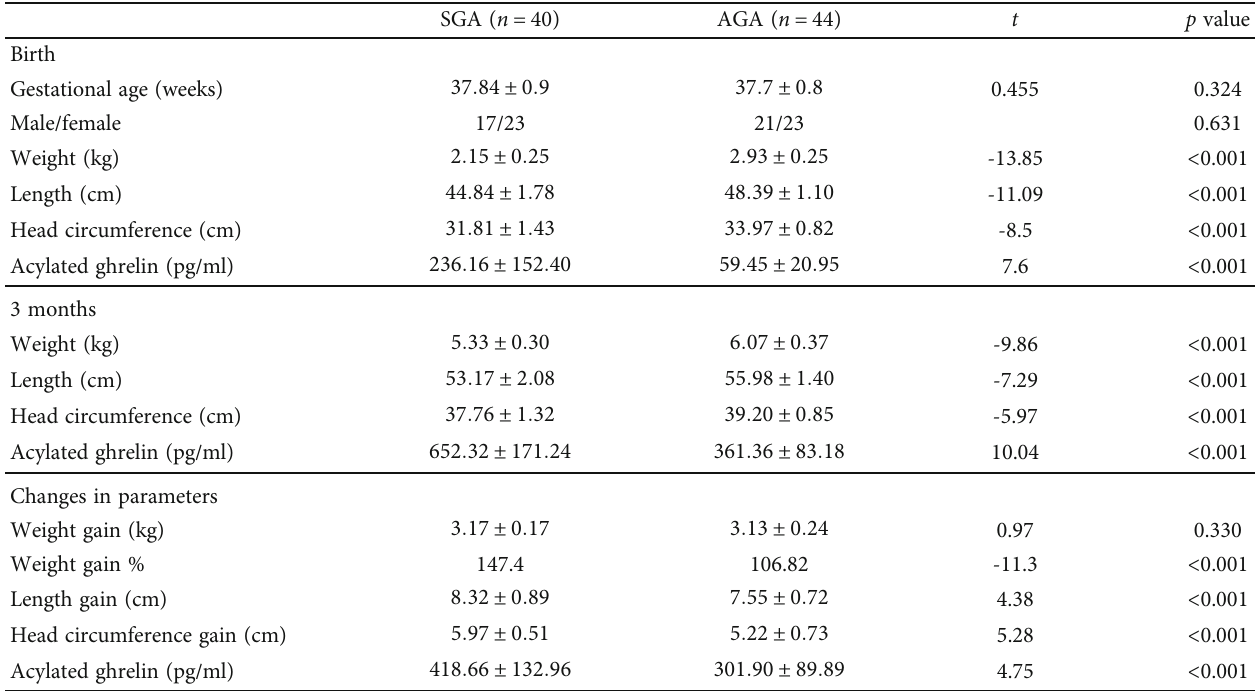
Table 1: Baseline anthropometry and acylated ghrelin concentrations in the study participants at birth and 3 months and changes in parameters.